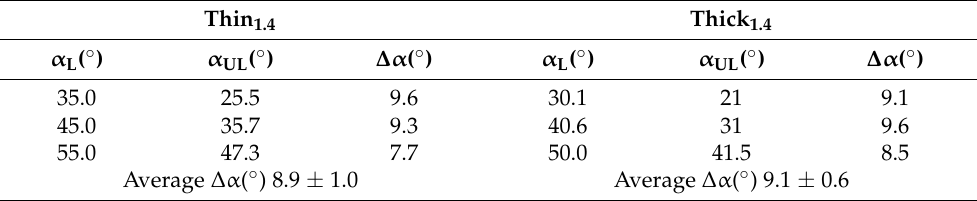
Table 3. The results of interrupted bending tests for the 1.4 mm Al–Si-coated steels.